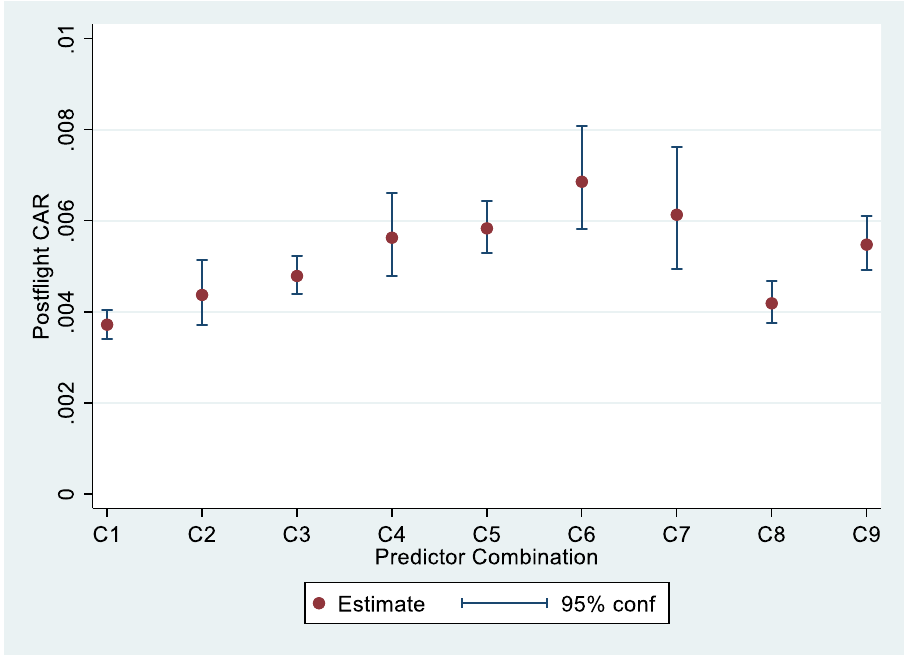
Figure 4. Predicted CAR and 95% confidence limits for 9 predictor